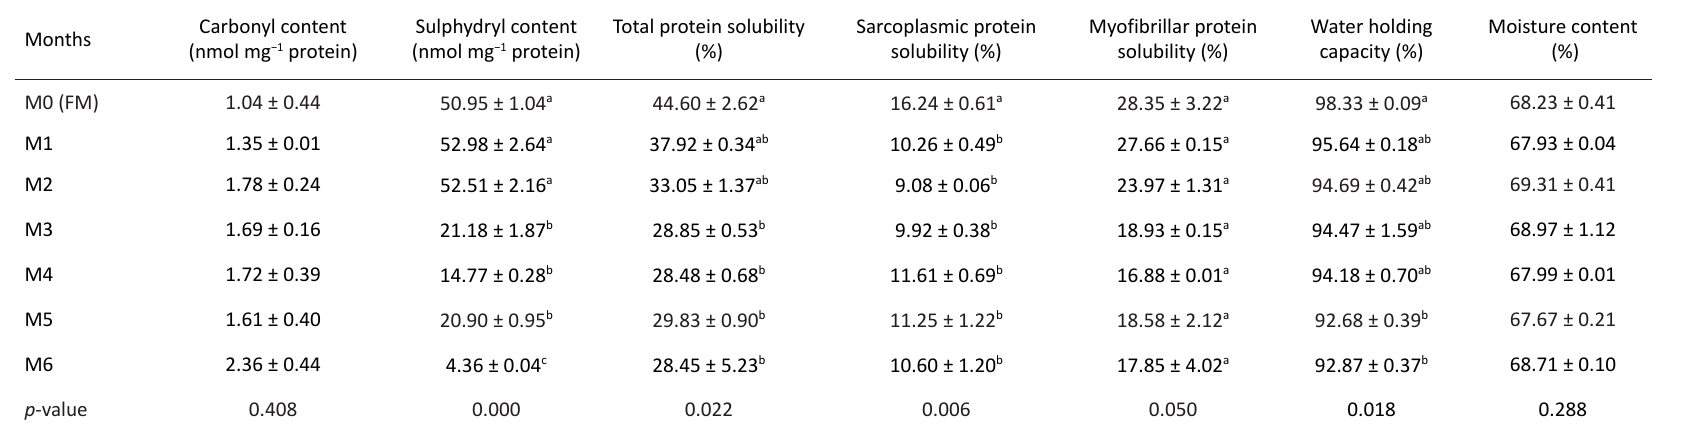
Table 2. Changes in the protein pattern of chicken thigh meat within 6 months of frozen storage (n=2)